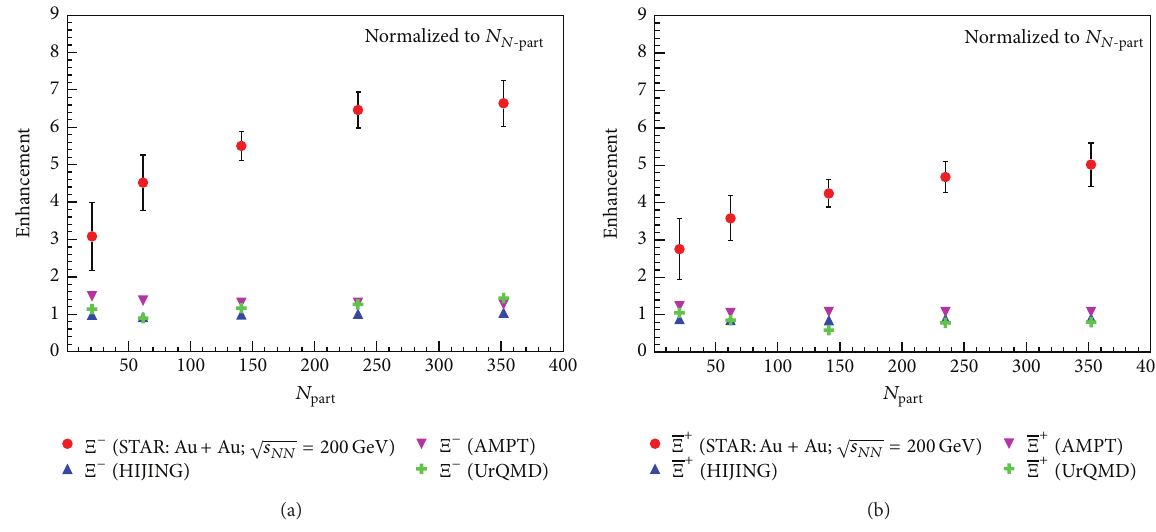
+ as a function of collision centrality for Au + Au collisions at √𝑠 𝑁𝑁 = 200 GeV